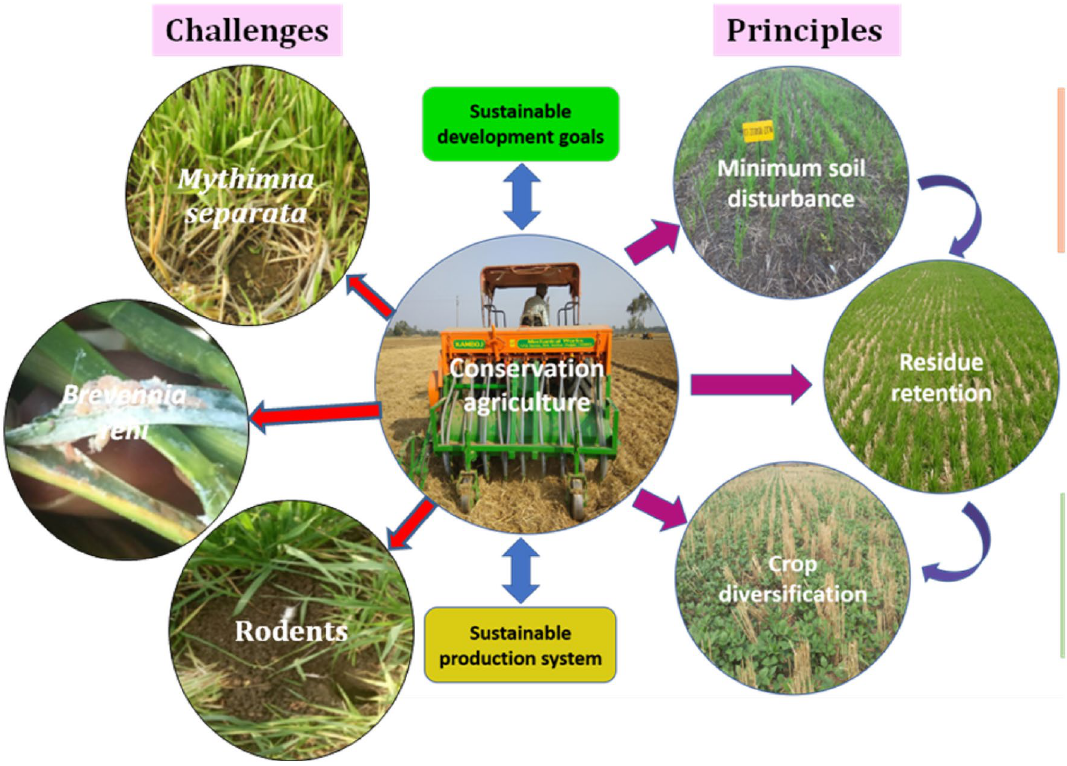
Figure 2. Schematic diagram of conservation agriculture (CA) production system with positivity and emerging issues in rice-based cropping systems of the middle Indo-Gangetic